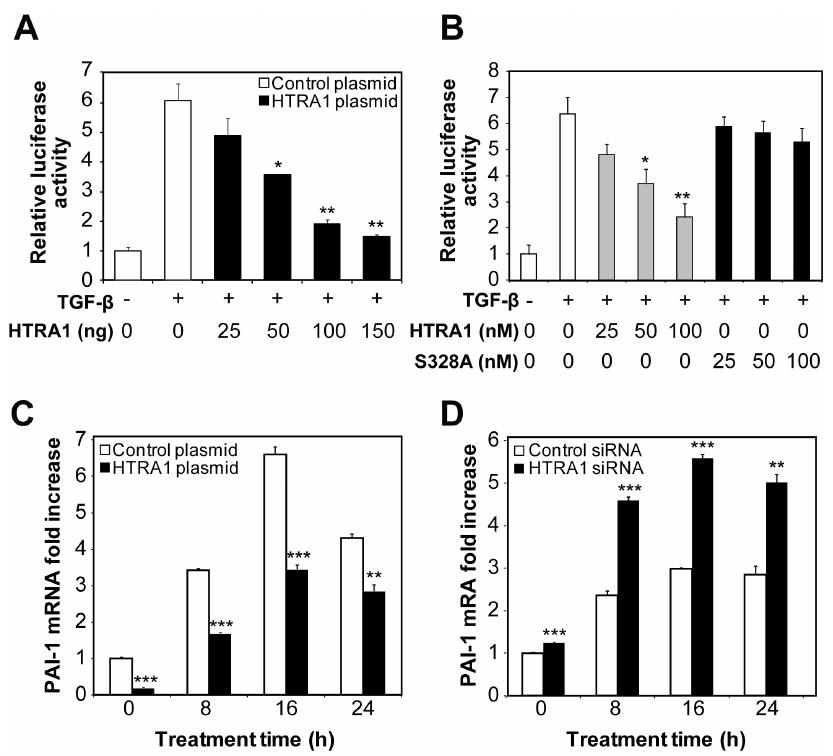
Figure 1. HTRA1 inhibits TGF- b -mediated transcription. ( A ) The effect of HTRA1 on TGF- b transcription was examined by co-transfecting HeLa cells with a luciferase reporter plasmid driven by tandem Smad responsive elements and with either control plasmid or 0, 25, 50, 100 or 150 ng of a plasmid that overexpresses HTRA1. After 24 hours, cells were either left untreated or treated with 10 ng/ml TGF- b for 16 hours to induce the Smad- responsive reporter gene. Relative luciferase activity was determined by calculating the ratio of firefly and Renilla luciferase activities. ( B ) The effect of exogenous treatment of HTRA1 on TGF- b -mediated transcription. HeLa cells were transfected with a Smad-responsive reporter and then either left untreated or treated with the indicated concentrations of purified HTRA1 or an inactive mutant, S328A. Relative luciferase activity was determined by calculating the ratio of firefly and Renilla luciferase activities. ( C ) TGF- b -induced expression of PAI-1 mRNA. HeLa cells were transfected with either a control plasmid or an HTRA1 plasmid, and then treated with 10 ng/ml of TGF- b for the indicated times. ( D ) Expression of PAI-1 mRNA in HeLa cells transfected with either a nonspecific control siRNA or with HTRA1 siRNA, then treated with 10 ng/ml of TGF- b for the indicated times. * P , 0.05, ** P , 0.01, *** P , 0.001, compared to TGF- b treated control ( A , B ), or empty plasmid and non-specific siRNA controls ( C , D ). Student’s t -test,